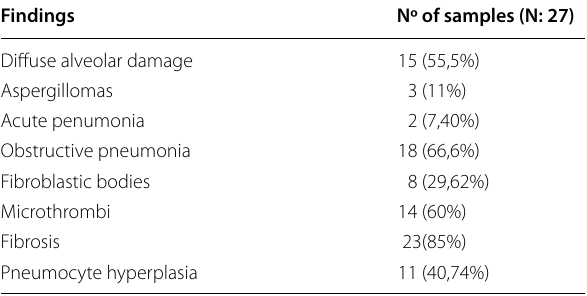
Table 1. Lung biopsy